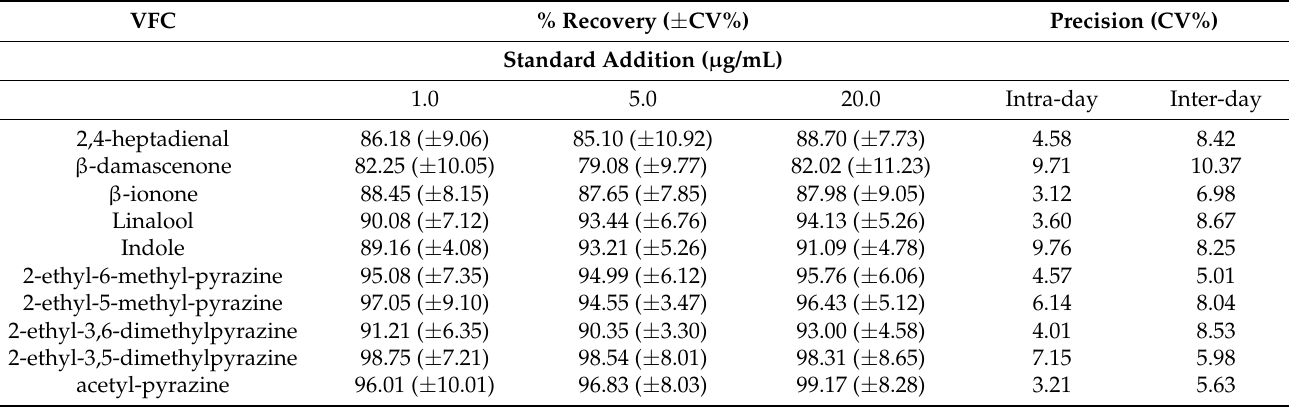
Table 4. Accuracy data from recovery experiments (n = 3) and precision data (intra-day precision, n = 6, inter-day precision, n =